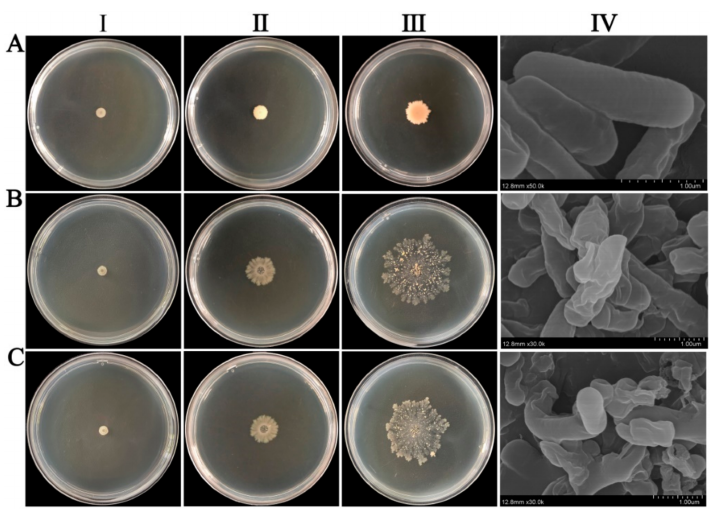
Figure 4. Injury effect of antimicrobial genes of C. globosum on B. subtilis cells. B. subtilis strains (SCK6-e) containing the empty vector and autolytic strains (CgR2150 and CgR3101) were placed on Luria-Bertani (LB) plates and incubated at 37 ◦ C. ( A-I ) B. subtilis SCK6-e strain, ( B-I ) CgR2150 and ( C-I ) CgR3101 after 12 h of incubation, and ( A-II ) B. subtilis SCK6-e strain, ( B-II ) CgR2150 , and ( C-II ) CgR3101 after 48 h of incubation, while ( A-III ) B. subtilis SCK6-e strain, ( B-III ) CgR2150 , and ( C-III ) CgR3101 after 192 h of incubation. ( A-IV ) B. subtilis SCK6-e strain, ( B-IV ) CgR2150 , and ( C-IV ) CgR3101 were observed under a scanning electron